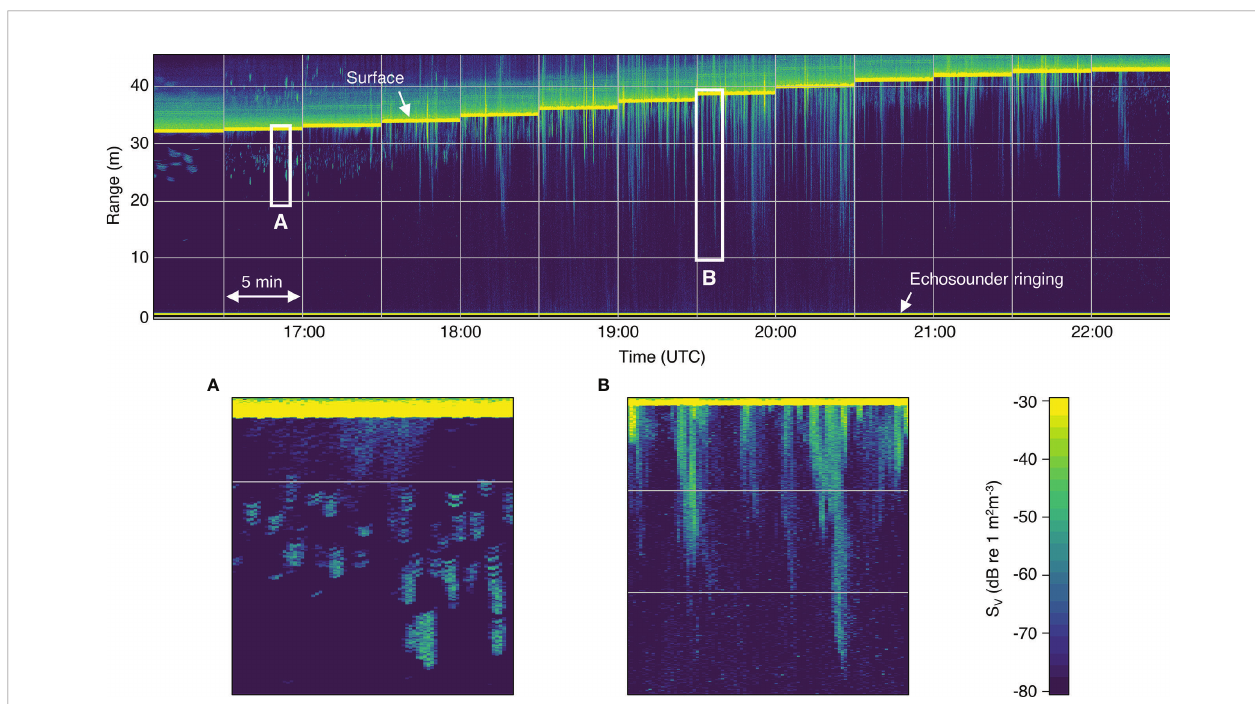
FIGURE 3 | Volume backscatter (S V ) echogram from a typical fl ood tide (on 22 May 2018). Low tide is on the left and high tide is on the right. Vertical gridlines separate the 5-min echosounder recording periods, which began every half hour (times shown in UTC). Horizontal gridlines indicate 10-m range bins (measured upwards from the transducer face). All following echograms use the same grid and color scale shown here. (A) Backscatter from small aggregations of fi sh visible near the surface near low tide. (B) Bubble plumes extending far into the water column during the peak fl